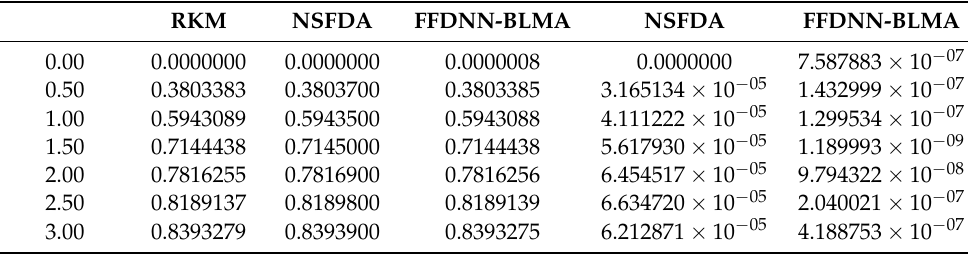
Table 2. Examination of the absolute errors and the predicted solutions calculated by the designed framework for the fluid speed with isothermal boundary